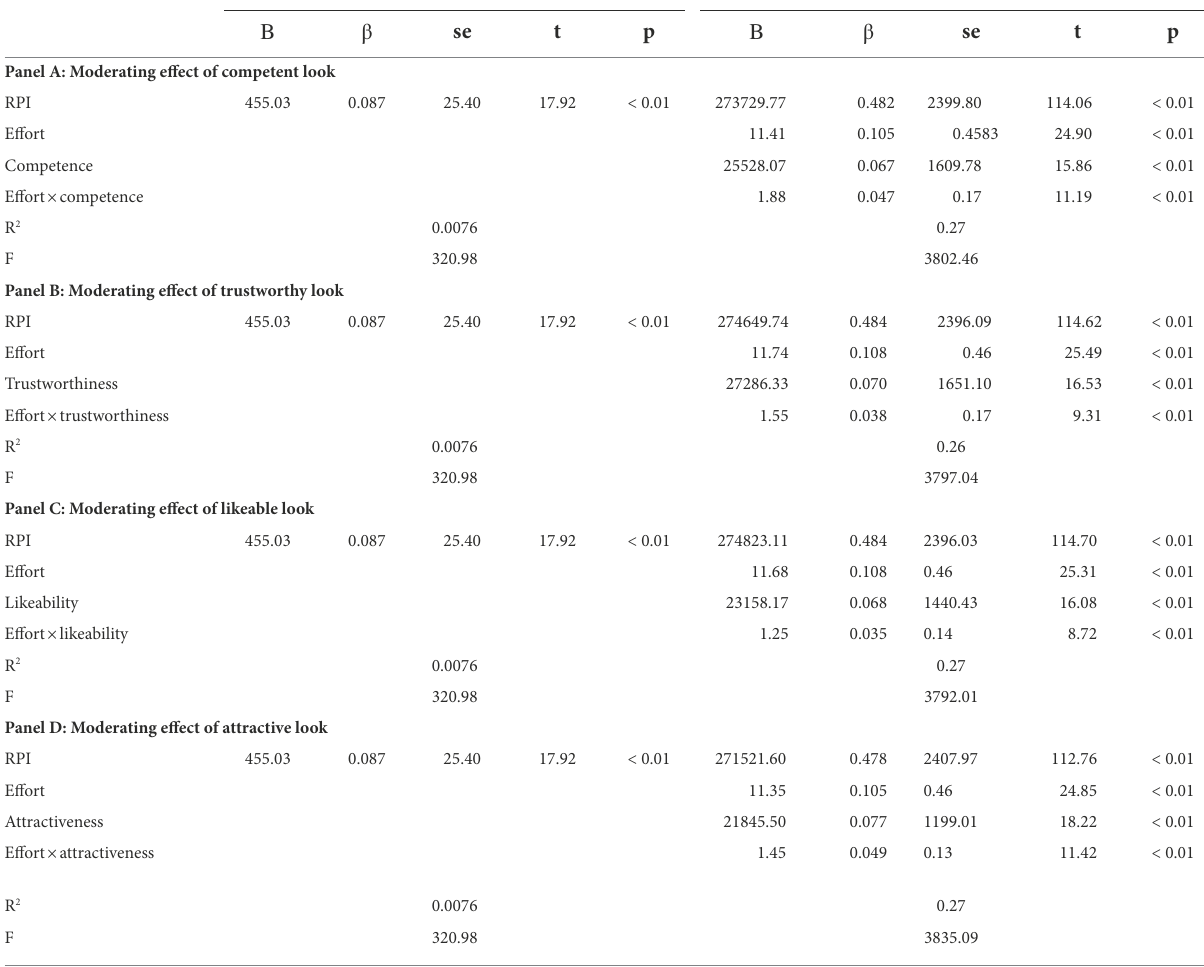
TABLE 4 Moderating effects of broadcaster appearance when mediated by broadcaster effort.